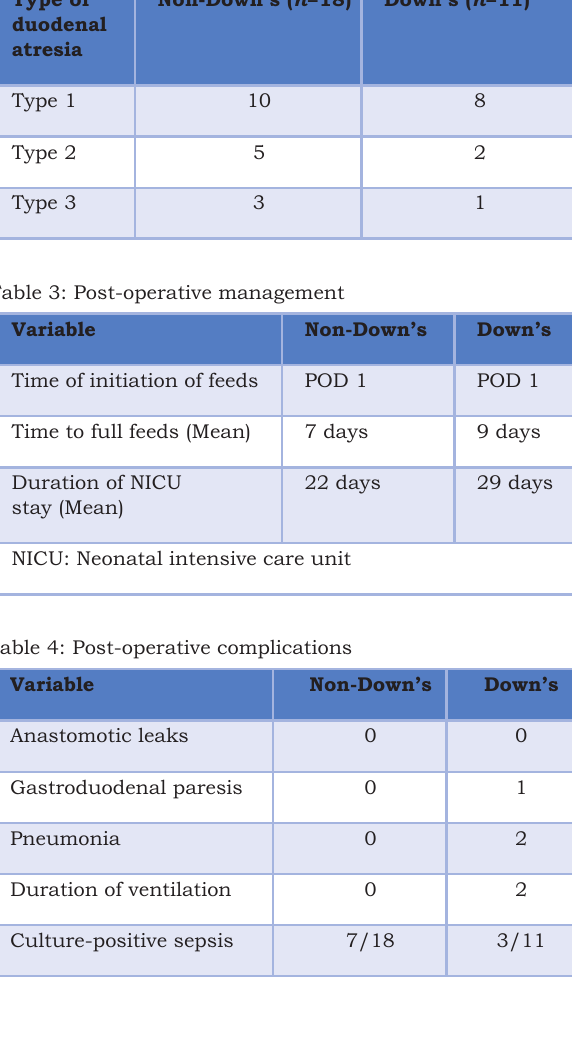
Table 2: Type of duodenal atresia Type of duodenal